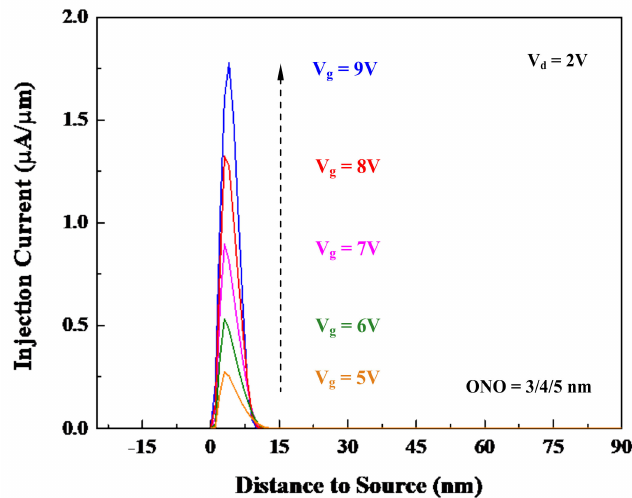
Figure 11. Distributions of electron injection currents in scaled double-gate Schottky barrier cells with various gate voltages from 5 to 9 V (V d = 2